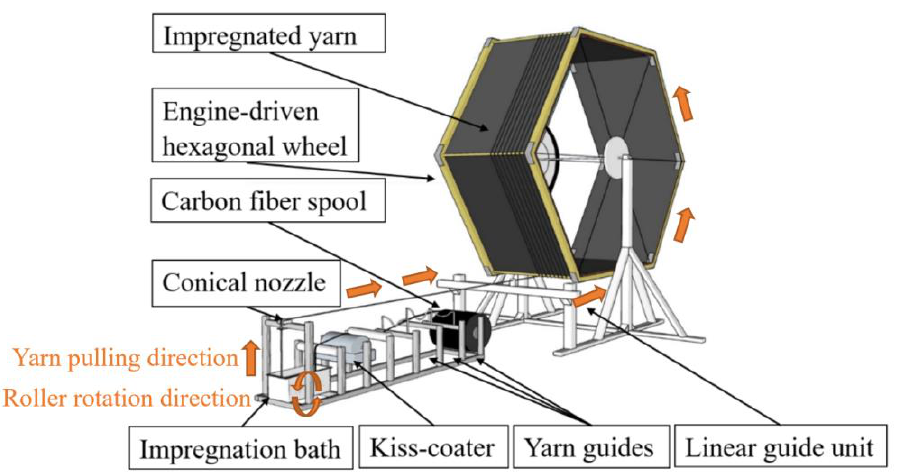
Figure 2. Scheme of the continuous, automated processing line for MCF.